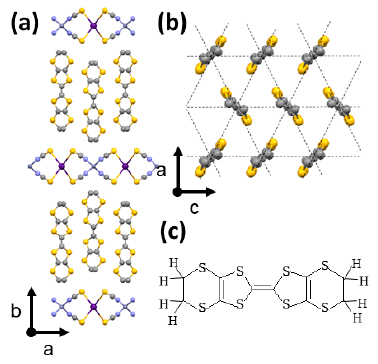
Figure 1. ( a ) Crystal structure of θ -(BEDT-TTF) 2 CsZn(SCN) 4 . The donor molecules and counter anions stack in a segregated structure. ( b ) The arrangement of the donor molecule of BEDT-TTF in the two-dimensional layer. The dashed line shows the triangle lattice in this arrangement. ( c ) The molecular structure of BEDT-TTF.